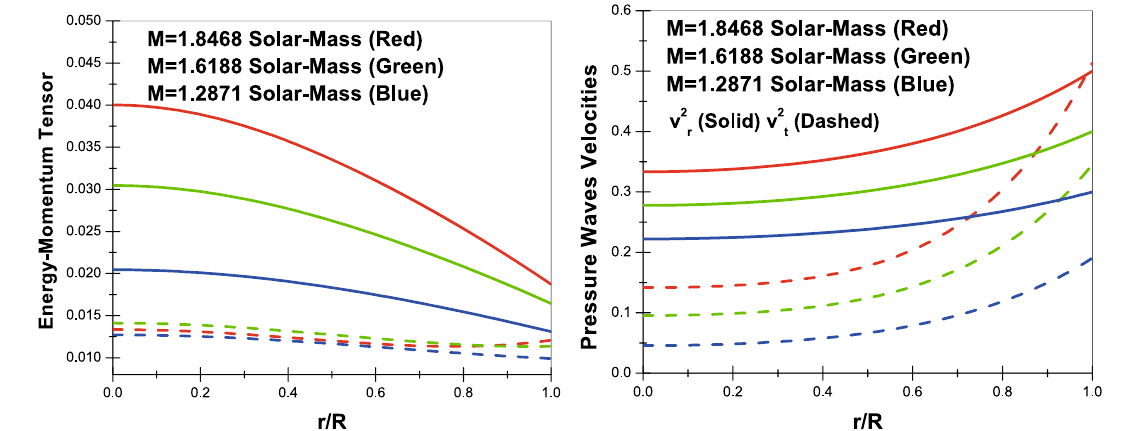
Fig. 3 Left Panel : The energy-momentum tensor against the dimen- sionless radial coordinate r / R . Solid lines correspond to ρ + p r + 2 p t anddashedlinesto ρ − p r − 2 p t . RightPanel :Thepressurewavesveloc- ities versus r / R . All these plots have been built by using R = 9 . 5 [ km ]